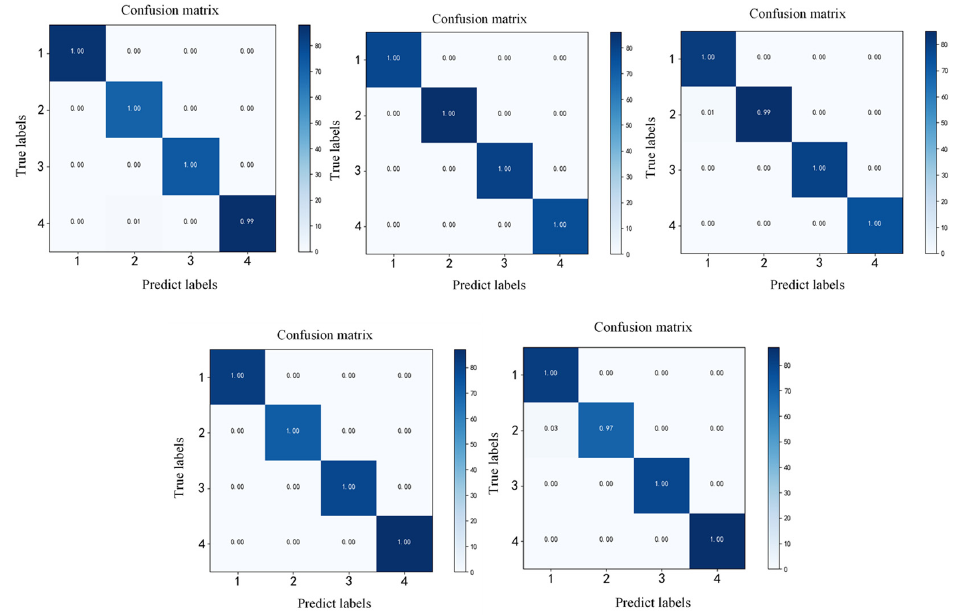
Figure 12. Defects classification confusion matrix.